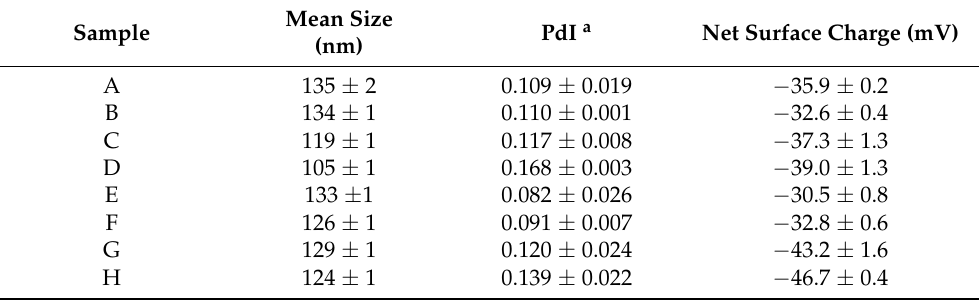
Table 2. Physicochemical parameters of ultradeformable nanocarriers formulation.